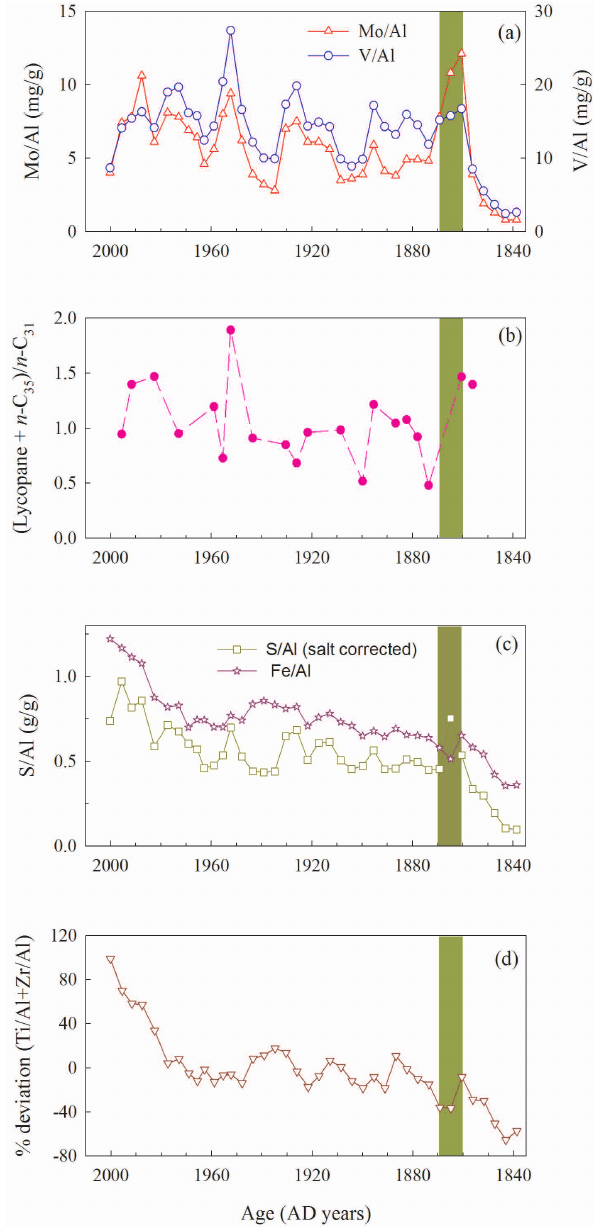
Fig. 4. Normalized bottom-water oxygenation proxies Mo/Al and V/Al (a) , (lycopane+ n -C 35 ) / n -C 31 ratio (b) , S/Al (salt corrected) and Fe/Al ratios (c) , and summation of percent deviation from the mean of terrigenous proxies Ti/Al and Zr/Al (d) . All the proxies correspond to core MUC-1B. Green area as in Fig.